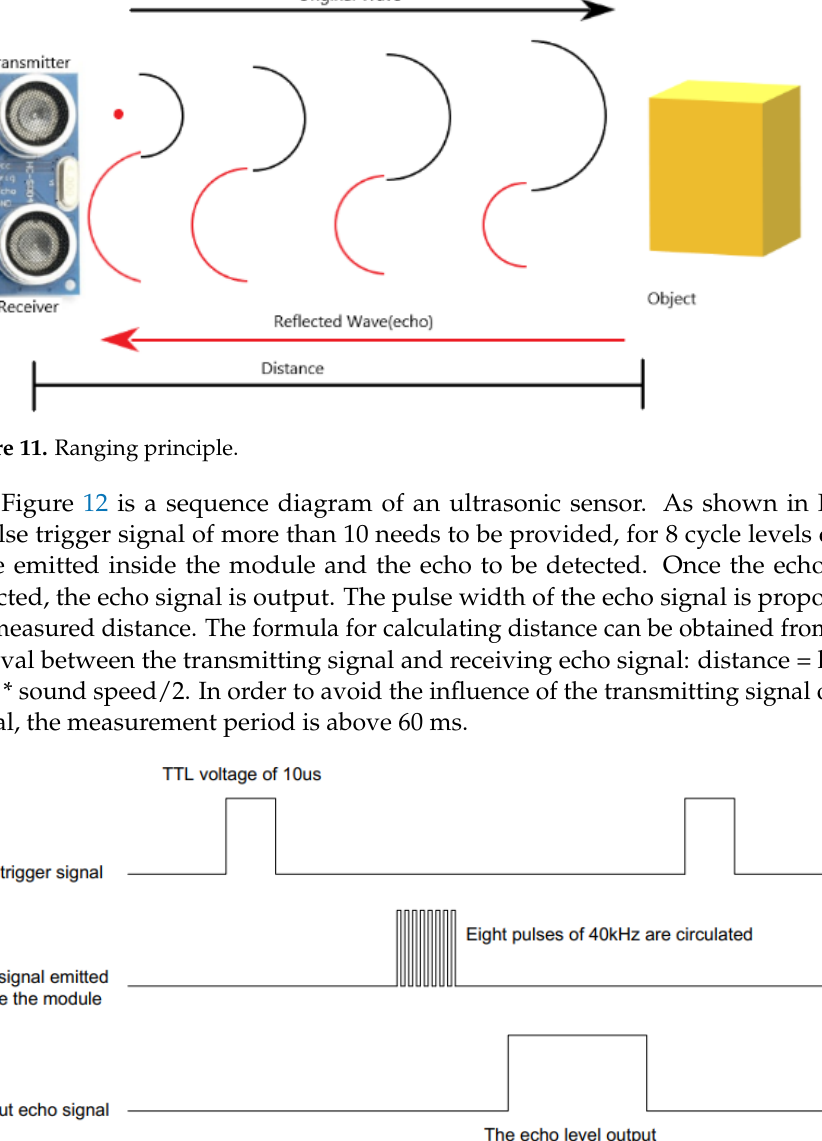
Table 3. Actual Distance and test distance. Actual Distance